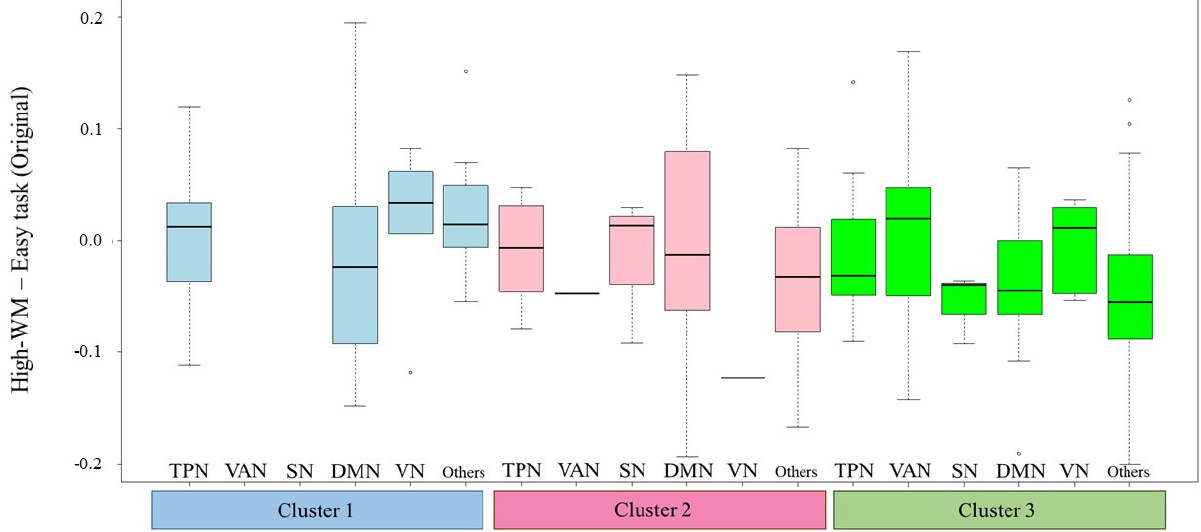
Figure 8. Boxplot of difference (High-WM–Low-WM) based on estimated clusters and